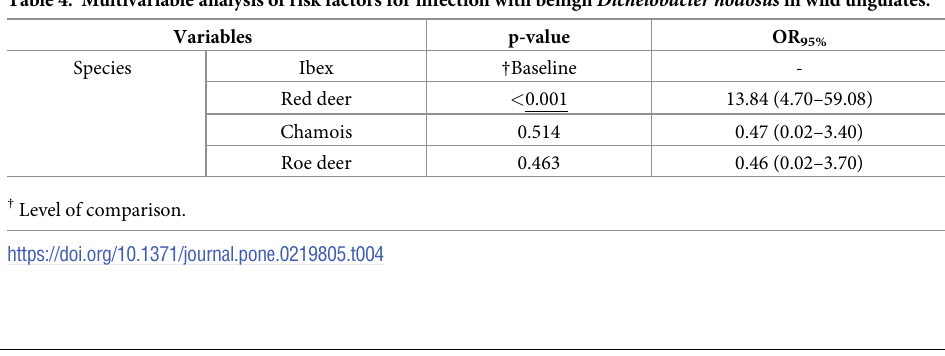
The variable “contacts” refers to reported interspecies interactions with wild and domestic ungulates (all D . nodosus positive wild animal species pooled) within a radius of 5km around the sampling location.